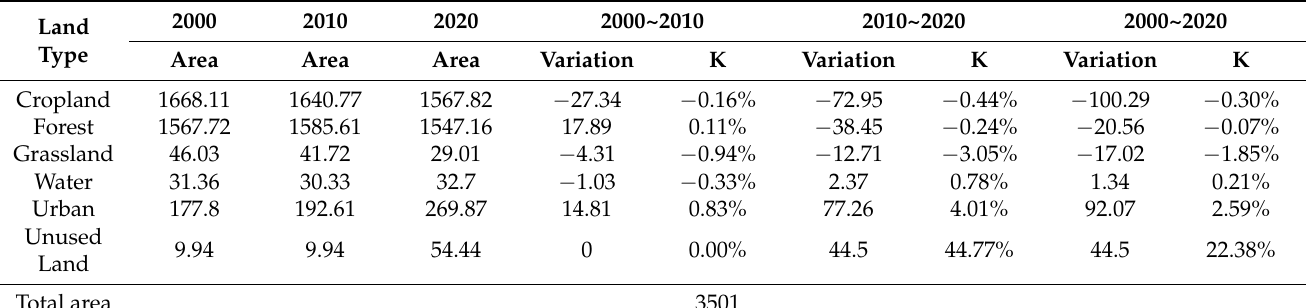
Table 6. Land use change area statistics of Ashe River Basin from 2000 to 2020 (km 2